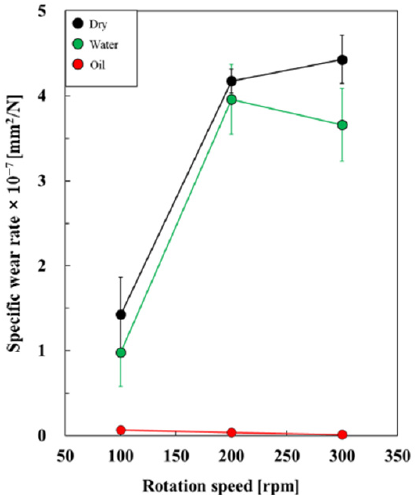
Figure 3. W s of AISI304 blocks against HSS disk obtained from wear tests under dry, water-, and oil-lubricated conditions.